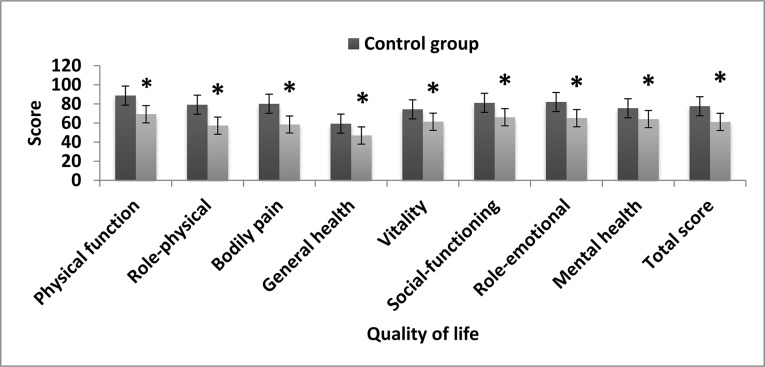
Comparison of SF-36 scores between the case group of elderly patients with osteoporosis (n = 112) and control group (n = 102).Values are reported as mean ± SEM. *Significantly different from the control group (P < 0.01).